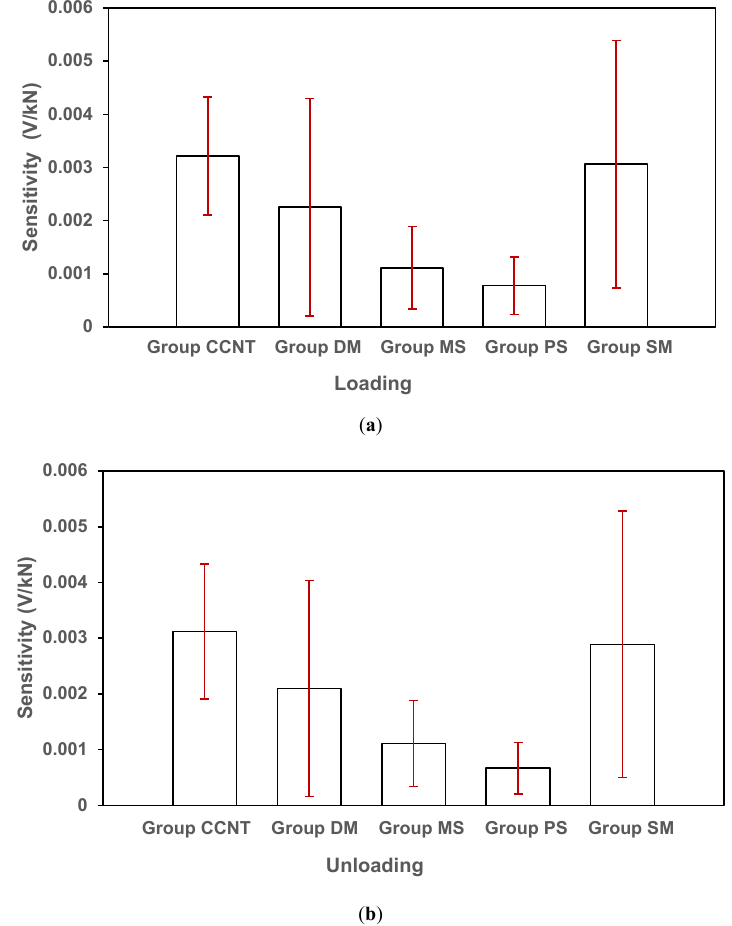
Figure 10. ( a ) Loading and ( b ) unloading sensitivities in the sample blocks made with CCNTs (copolymer method, Group CCNT), bare CNTs (direct mixing method, Group DM), no CNTs but copolymer (Group MS) and no CNTs and copolymer (Group PS) and surface modified CNTs (surfactant method, Group SM) and. The vertical error bars represent standard deviations. Table 3. Comparisons of force sensitivity and hysteresis.